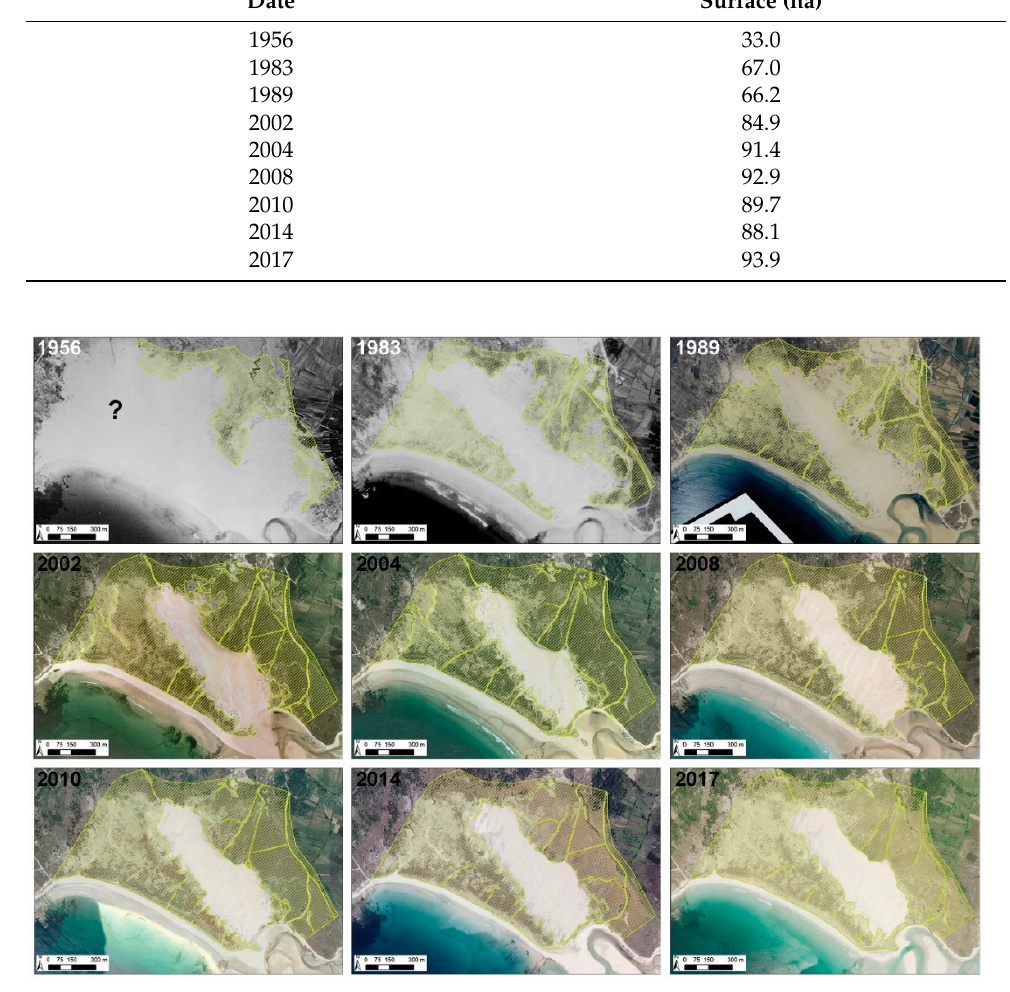
Figure 6. Evolution of vegetation coverage since 1956 to 2017. The light green polygons represent the vegetation on the aerial images and orthophotographs of each data. The symbol (?) in this part of the Figure indicated that in that moment (1956) was not possible identify the large dune extension and their